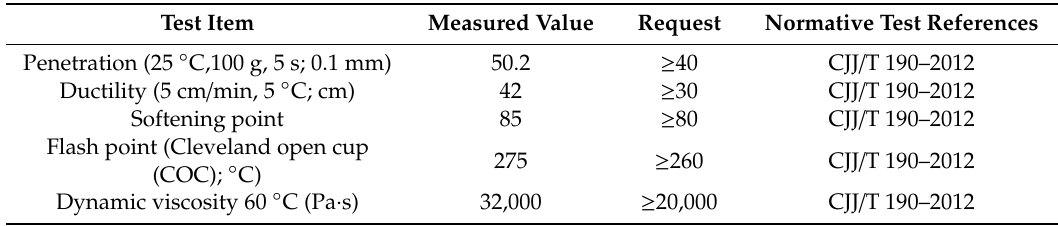
Table 3. Main technical bitumen